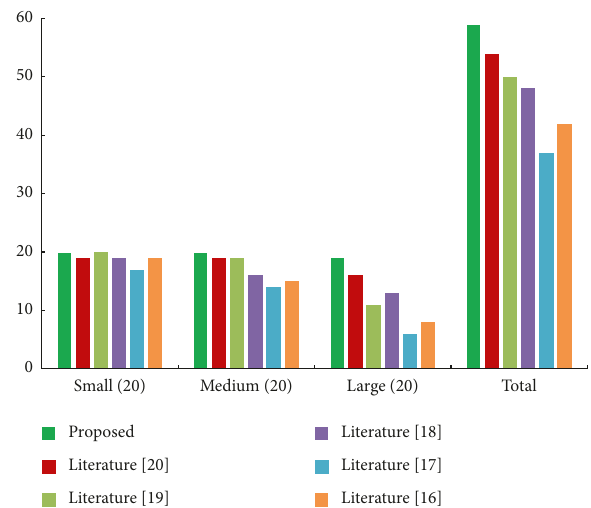
Figure 6: Result comparison of different algorithms on Lewis 60